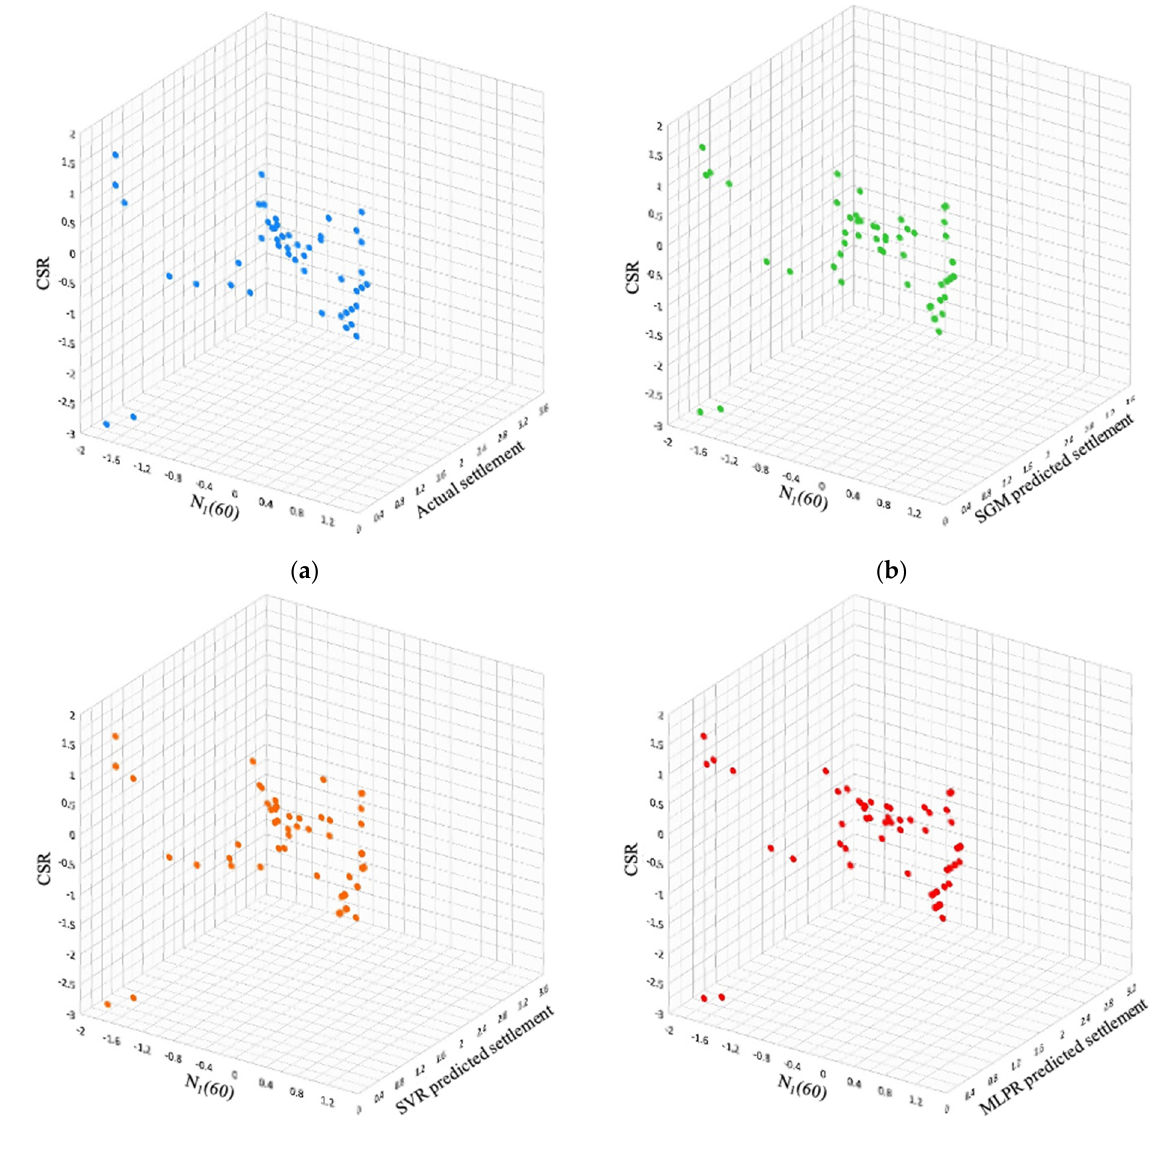
Figure 11. Settlement comparison with CSR and N 1 (60) features of SPT. ( a ) Actual settlement; ( b ) SGM-predicted settlement; ( c ) SVR-predicted settlement; ( d ) MLPR-predicted settlement.